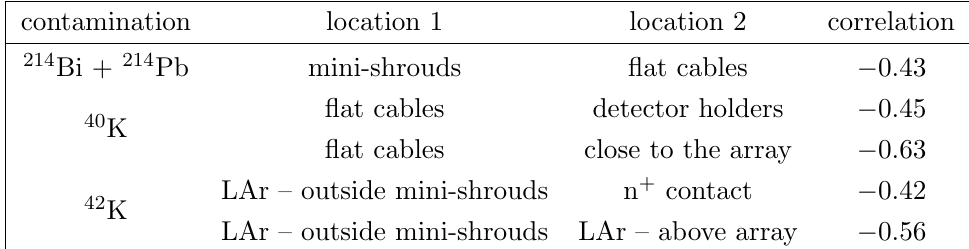
Table 3. Correlations between (cid:12)t components relative to the same background contamination in di(cid:11)erent